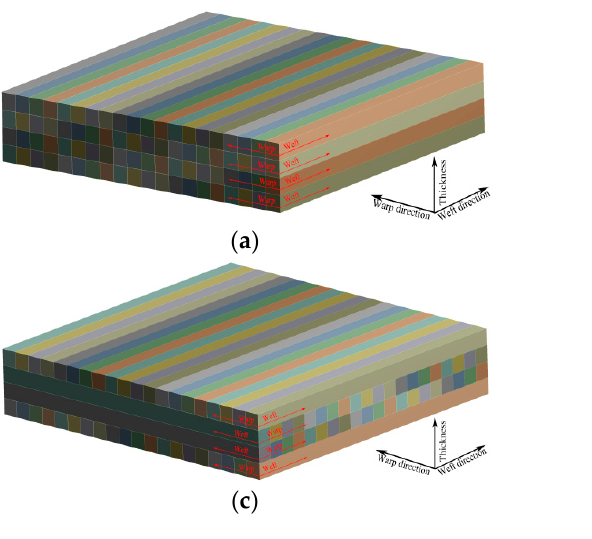
Figure 9. Schematic diagram of different laying methods. ( a ) Unidirectional laying method. ( b ) Orthogonal laying method. ( c ) Symmetrical laying method. ( d ) 2/2 laying method.